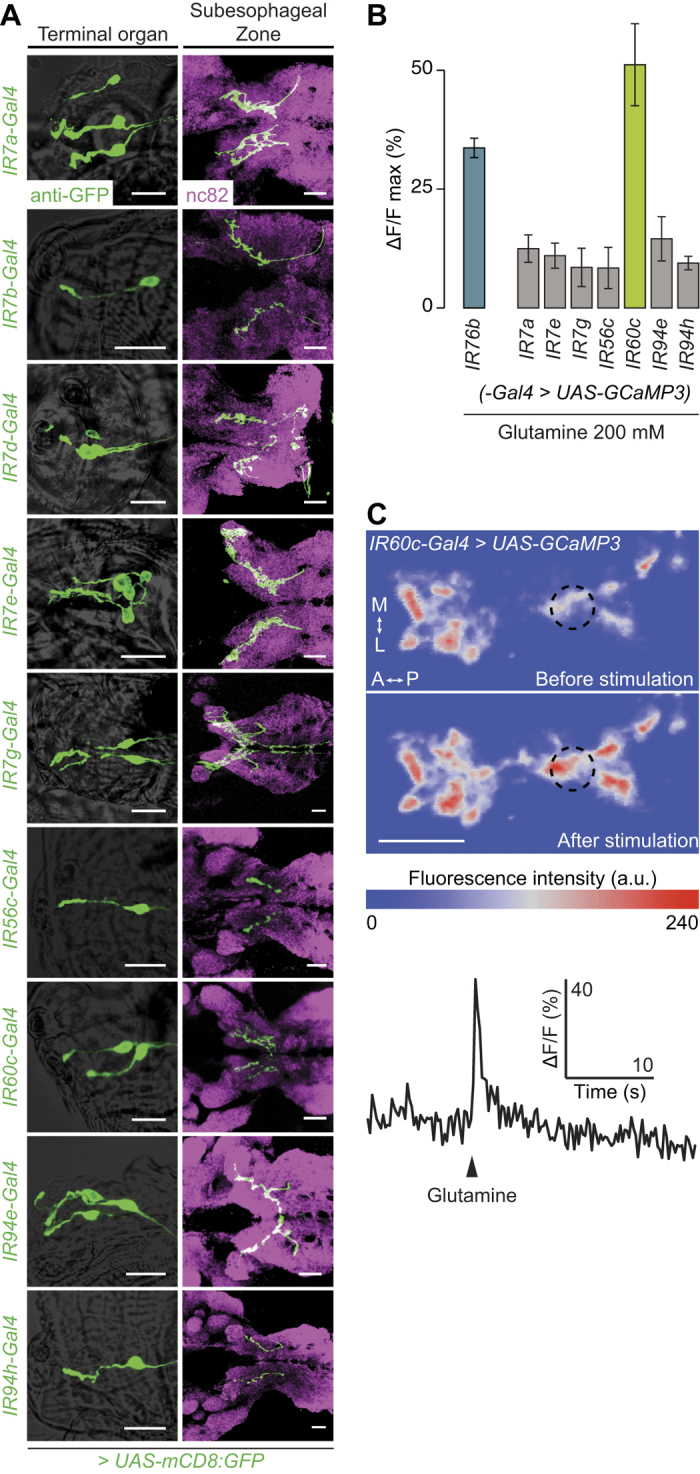
Identification of a single neuronal population responsive to amino acids.(A) Expression patterns of nine IR-Gal4 lines (visualised with a UAS-mCD8:GFP reporter) that label subsets of gustatory neurons in the Terminal Organ (genotypes of the form: UAS-mCD8:GFP;IRxx-Gal4). Left: soma and dendrites of IR-Gal4 neurons in the Terminal Organ (anti-GFP, green, overlaid on a brightfield image). Right: projection pattern of IR-Gal4 neuron axons in the SEZ (anti-GFP, green), overlaid on the neuropil marker nc82 (magenta). Scale bars: 20 μm. (B) Peak ΔF/F values of calcium responses measured in the indicated IR-Gal4 neurons (genotypes of the form: UAS-GCaMP3;IRxx-Gal4) to presentation of glutamine (200 mM; preliminary observations prompted our use of higher concentrations than in Fig. 3, to ensure detection of responses in the sparse innervations of individual populations of IR-Gal4 neurons). IR7b-Gal4 and IR7d-Gal4 were excluded because the basal GCaMP3 fluorescence with these drivers was too low to perform imaging experiments. (Mean response ± SEM is shown; N ≥ 5 animals per stimulus). (C) Top: False-coloured representation of GCaMP3 fluorescence intensity in one hemisphere of the SEZ of a UAS-GCaMP3;IR60c-Gal4 animal, before and after presentation of 200 mM glutamine. Scale bar: 20 μm. Bottom: example time course of the calcium response of IR60c-Gal4 neurons to glutamine presentation (arrowhead) from the region of interest indicated by a dashed circle on the upper panels.